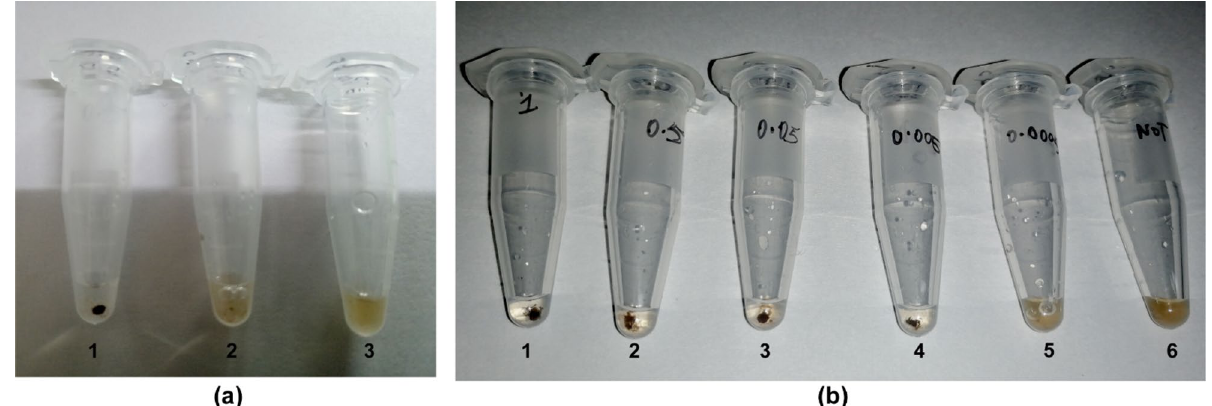
Figure 8. Detection by bridge flocculation method. ( a ) Visual flocculation of amplified product. Positive sample (1) shows distinct flocculation whereas MTB control (2) and No template control (3) appear brown with no flocculation ( b ) Sensitivity determination of flocculation method. Different dilutions, 1 ng/μl (1), 0.5 ng/ μl (2), 0.05 ng/μl (3), 5 pg/μl (4), 0.5 pg/μl (5) template DNA were used for LAMP and bridge flocculation detection alongwith No template control